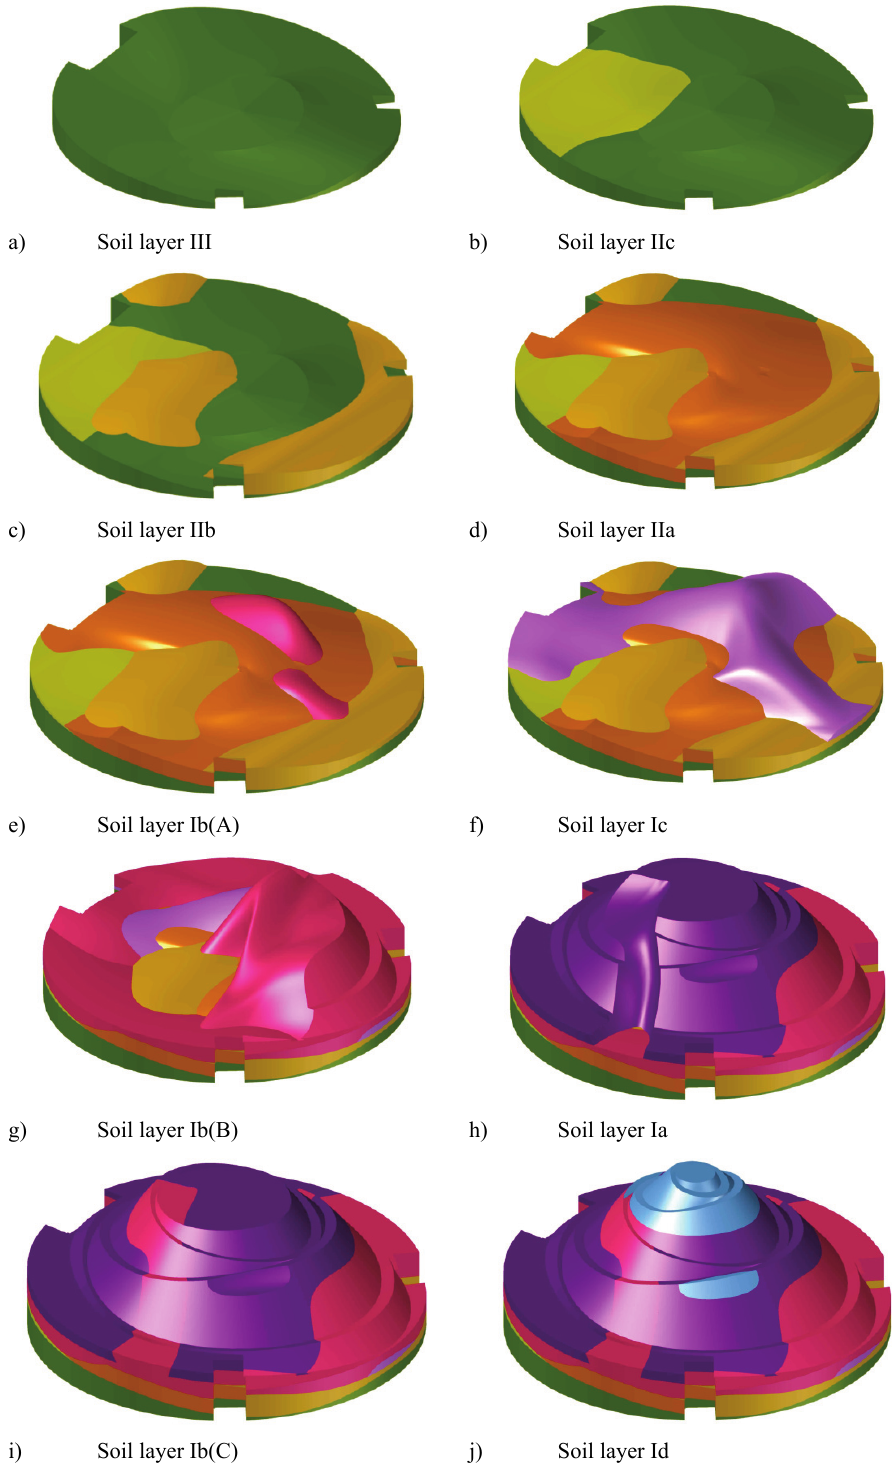
Fig. 1. Soil layers of the Ko ś ciuszko